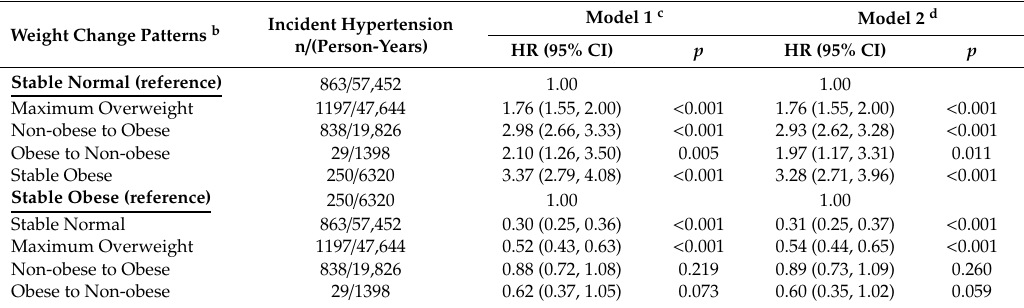
Table 2. Hazard ratios (HRs) and 95% confidence intervals (CIs) of incident hypertension with weight change patterns across adulthood a .